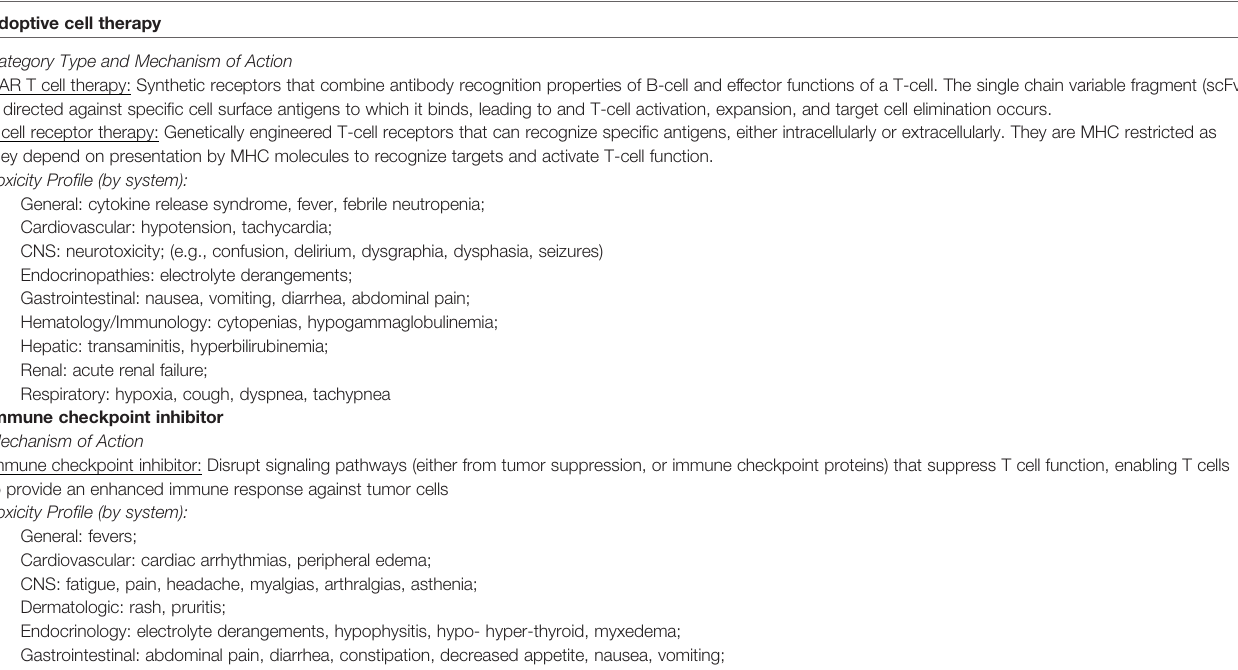
TABLE 1 | Types of immunotherapy, mechanism of action, systemic toxicity. Adoptive cell